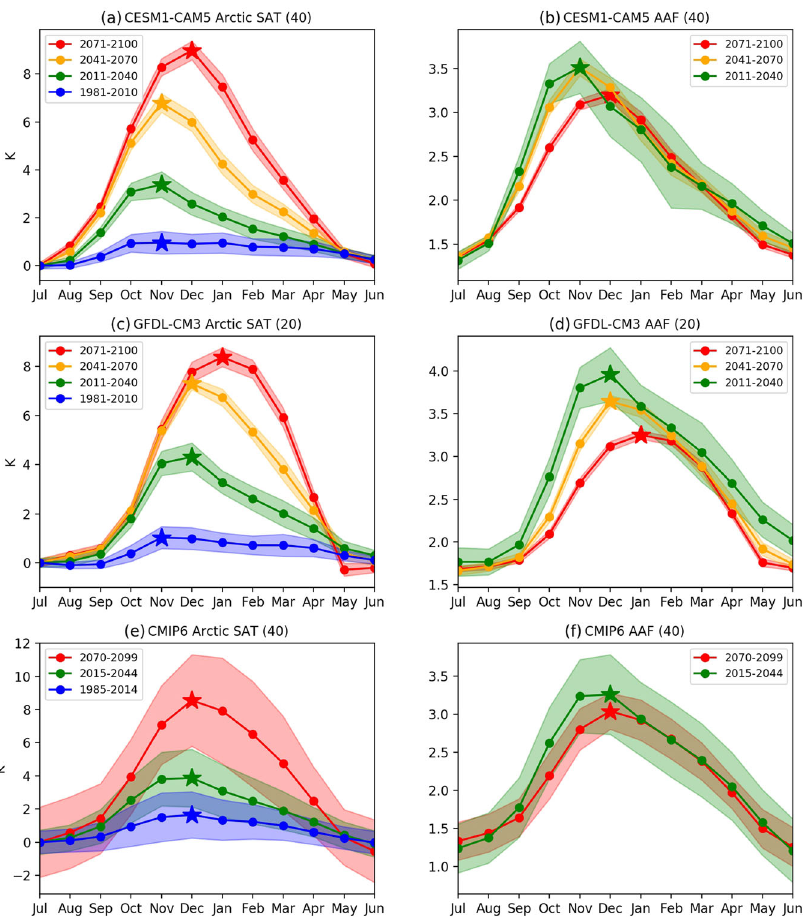
Fig. 5 Seasonal evolutions of the Arctic SAT responses and AAF in the CESM1 and GFDL-CM3 SMILEs, and the CMIP6 models. a The evolution of Arctic SAT responses (reference to 1921 – 1950 averages) in CESM1 SMILE. b Similar as ( a ) but for AAF. c , d Similar as ( a ), ( b ) but for GFDL-CM3 SMILE. e , f Similar as ( a ), ( b ) but for multi-model mean of 40 CMIP6 models. In a – d , the solid line represents ensemble means and the color shading indicates one standard deviation across ensemble members. In e , f , the solid line represents multi-model means and the color shading indicates one standard deviation across models. In a , c , e , all values are referenced to July values. The ensemble or model size is labeled in the parenthesis of each